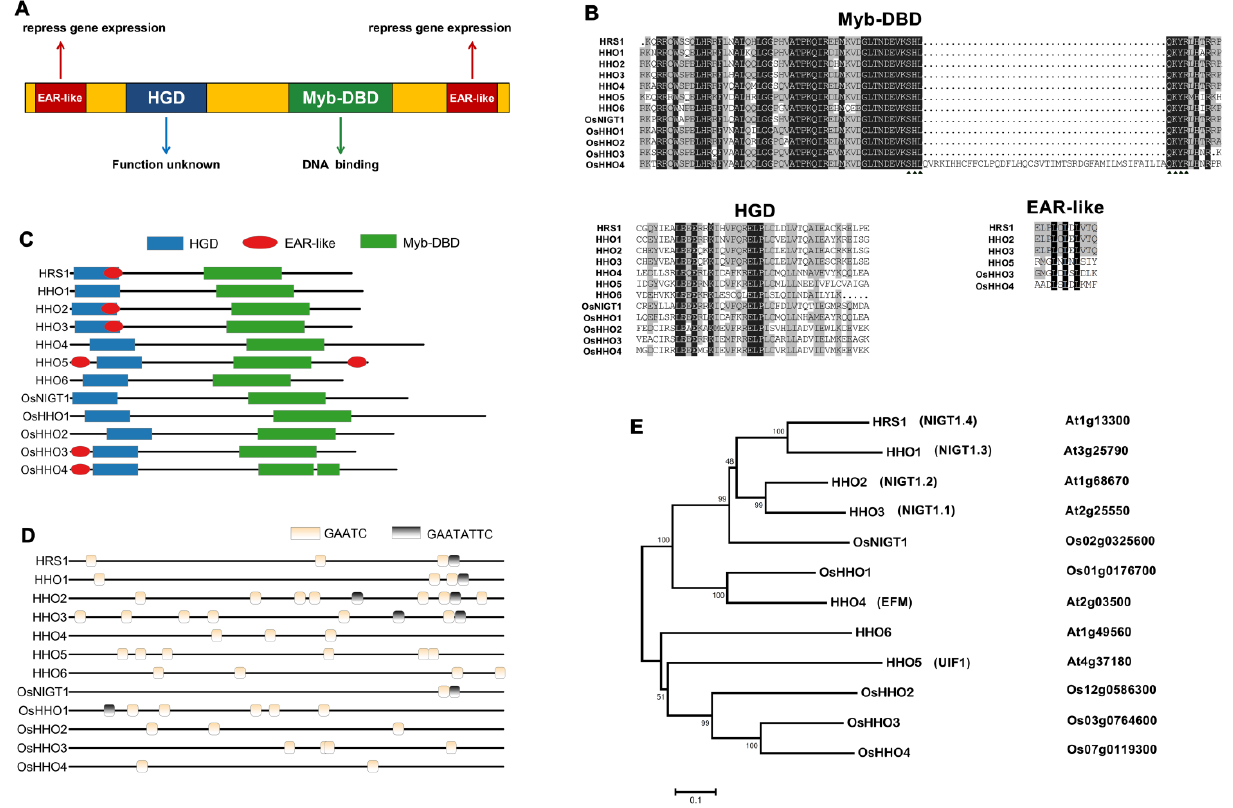
Figure 1. Classification and structure of the NIGT1/HRS1/HHO family. ( A ) The structural model of the NIGT1/HRS1/HHO family consisting of three types of conserved domains: Myb-DBD (green), HGD (blue), and EAR like (red). ( B ) The sequence alignment of the conserved domains of the NIGT1/HRS1/HHO family. Fully conserved amino acids are shaded in